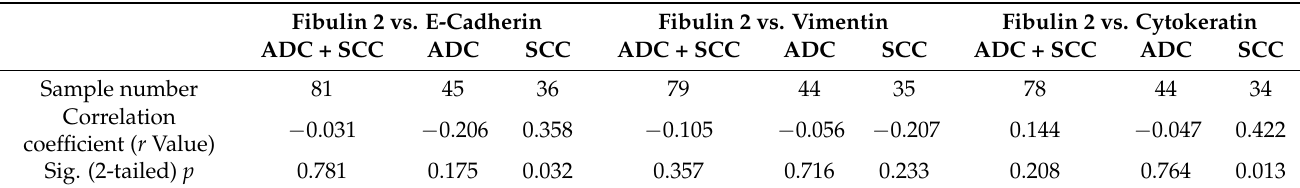
Table 3. Pearson correlation coefficients between fibulin 2 and E-cadherin, vimentin and cytokeratin protein expression in primary lung